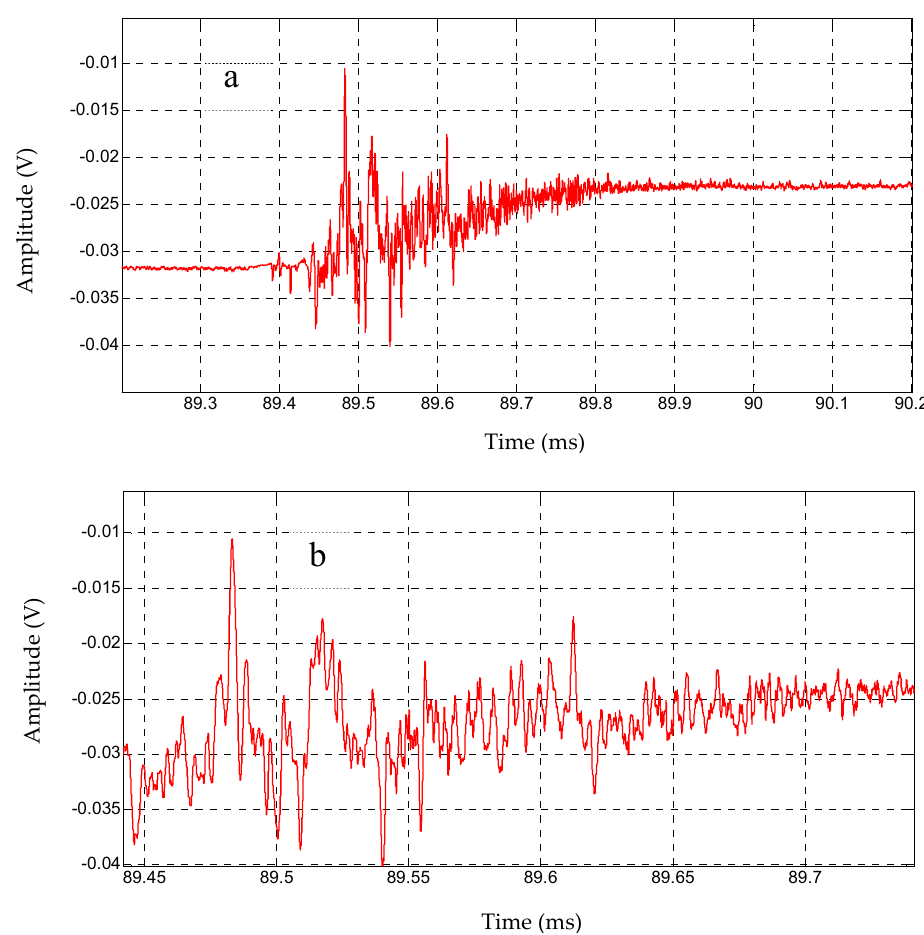
Figure 9. ( a ) K-change consists of a chaotic pulse train, ( b ) Expanded view of the chaotic pulses. Data were recorded on 4/5/2013 20:06:00. UTC.